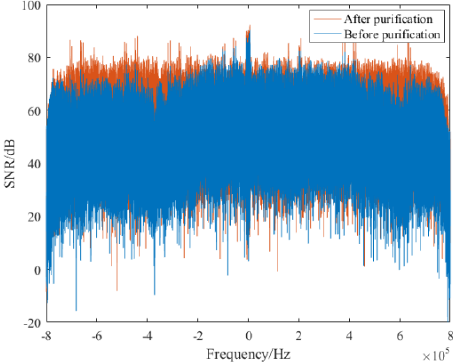
Figure 13. Correlation results: ( a ) reference signal before purification; ( b ) reference signal after purification.